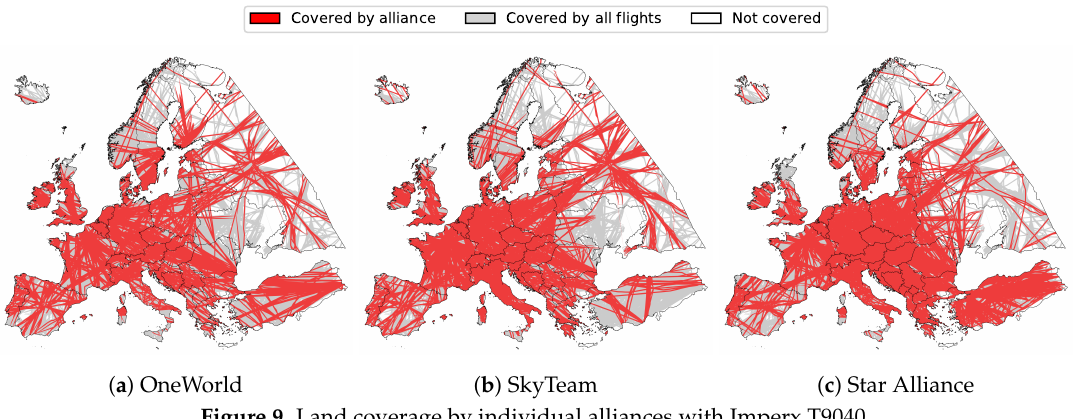
Figure 9. Land coverage by individual alliances with Imperx